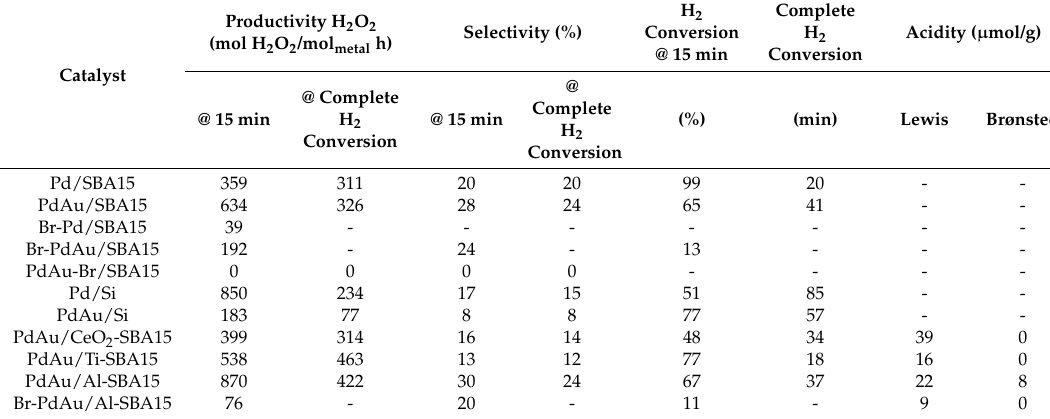
Table 2. H 2 O 2 synthesis with SBA15 supported catalysts: acidity, H 2 conversion after 15 min of reaction, productivity and selectivity (after 15 min of reaction and at complete H 2 conversion). Reprinted by permission from Springer Nature: Springer Nature, Topics in Catalysis, 56, 540–549, Reactivity Aspects of SBA15-Based Doped Supported Catalysts: H 2 O 2 Direct Synthesis and Disproportionation Reactions, N. Gemo, P. Biasi, P. Canu, F. Menegazzo, F. Pinna, A. Samikannu, K. Kord á s, T. O. Salmi, J.-P. Mikkola, Copyright